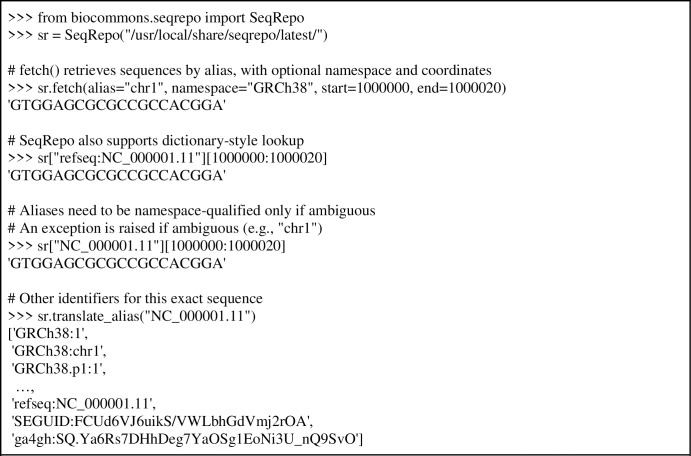
Examples of the native Python interface.SeqRepo retrieves sequences and metadata using conventional identifiers (i.e., from NCBI, Ensembl, GRCh, LRG, and other sources) and from digest identifiers (i.e., sha512t24u, ga4gh, md5, SEGUID). Identifiers are namespaced, and generally written as "<namespace>:<alias>". Aliases are always unique within a namespace. See the SeqRepo repository for installation instructions and S2 Code for example details.